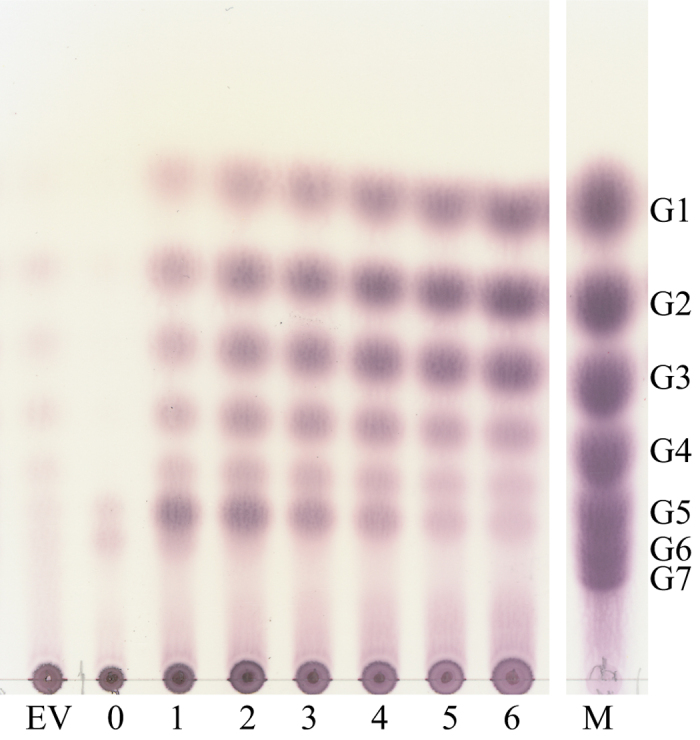
TLC analysis of MaAmyB products obtained in time by incubation of the enzyme (155 U, CNP assay) with soluble potato starch up to 6 h.EV = empty vector control incubated for 6 h. M = markers, size consisting of G1–G7 (glucose; maltose; maltotriose; maltotetraose; maltopentaose; maltohexaose; maltoheptaose).